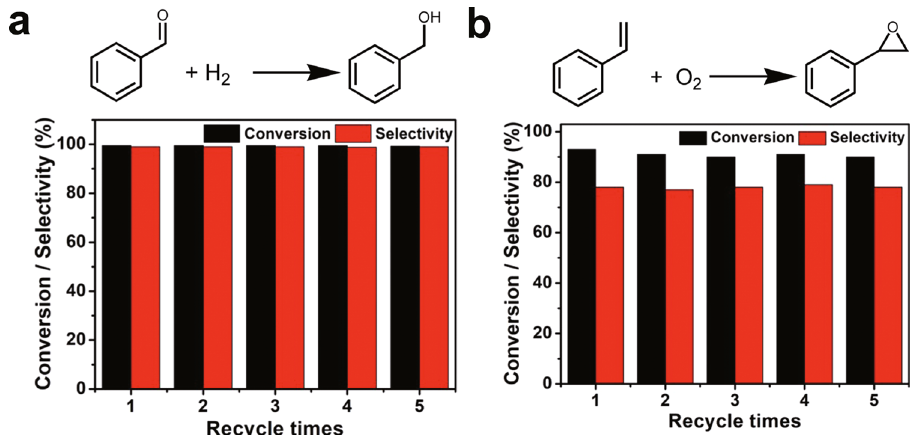
Fig. 6 Hydrogenation of benzaldehyde and epoxidation of styrene. a Catalytic performance for the hydrogenation of benzaldehyde by using the Pt 2 /mpg- C 3 N 4 catalyst. b Corresponding catalytic performance for the epoxidation of